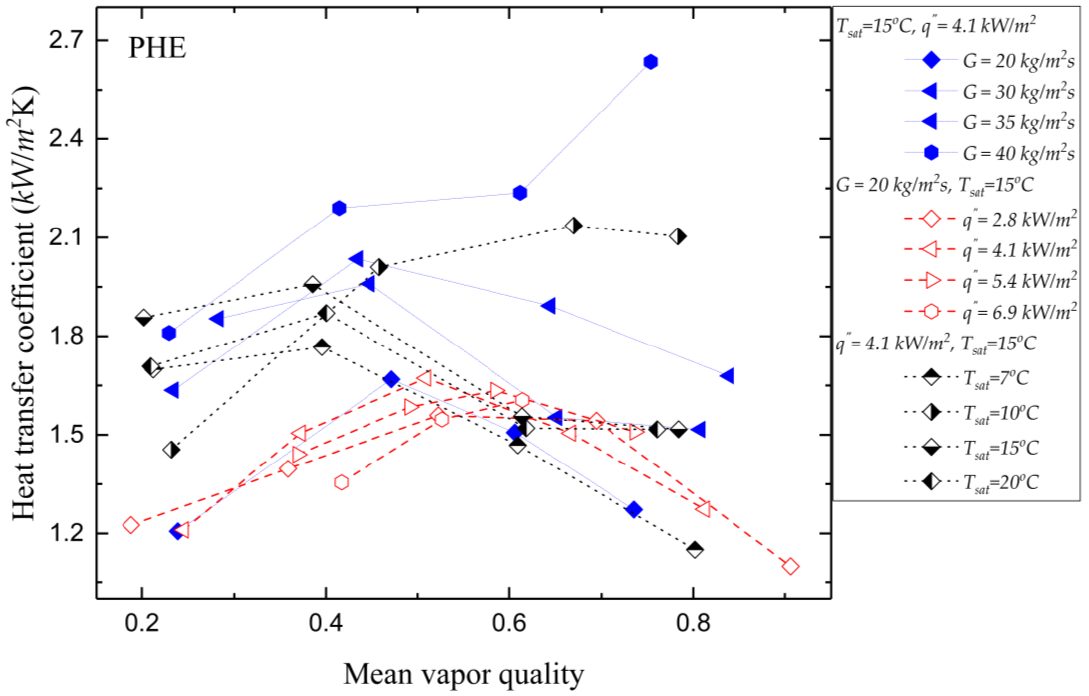
Figure 18. Average evaporation HTC comparison of R-1234ze(E) in a PHE at variable operating conditions [15].